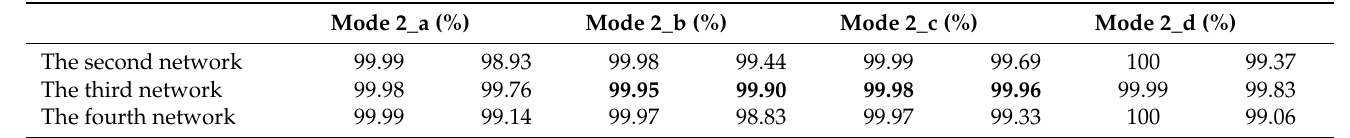
Table 5. The best accuracies for different networks under different data division modes.